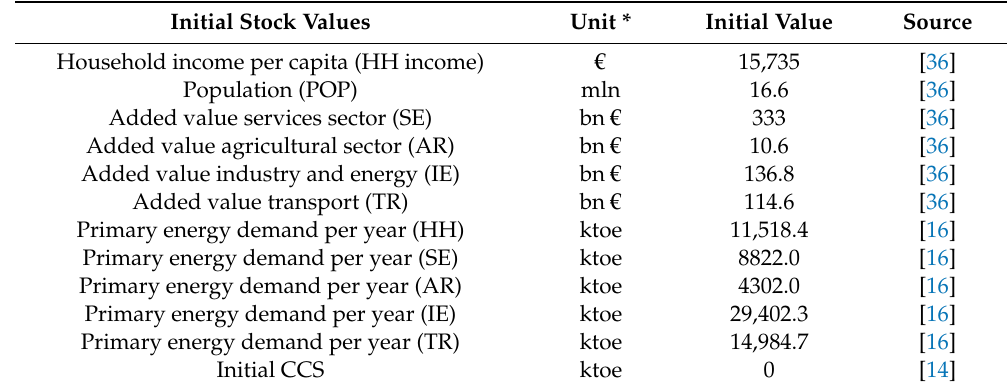
Table 1. Initial stock values (price level = 2010) for the demographic sub-system.